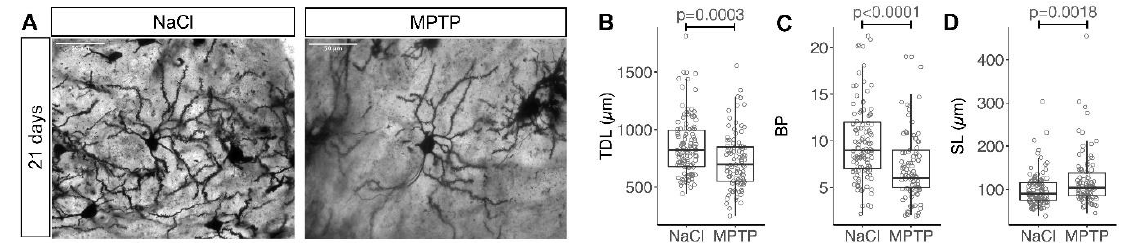
Figure 2. Dendritic arborization of striatal MSN 21 days after MPTP. ( A ) Representative images of Golgi stained MSN in the striatum analyzed 21 days after the last MPTP injection. Scale bars 50 μm. ( B ) Total dendritic length (TDL), ( C ) number of branch points (BP) per MSN, ( D ) segment length (SL = TDL / BP). Each marker represents one MSN. Numbers of MSN are in Table 1. p -values are from Mann–Whitney